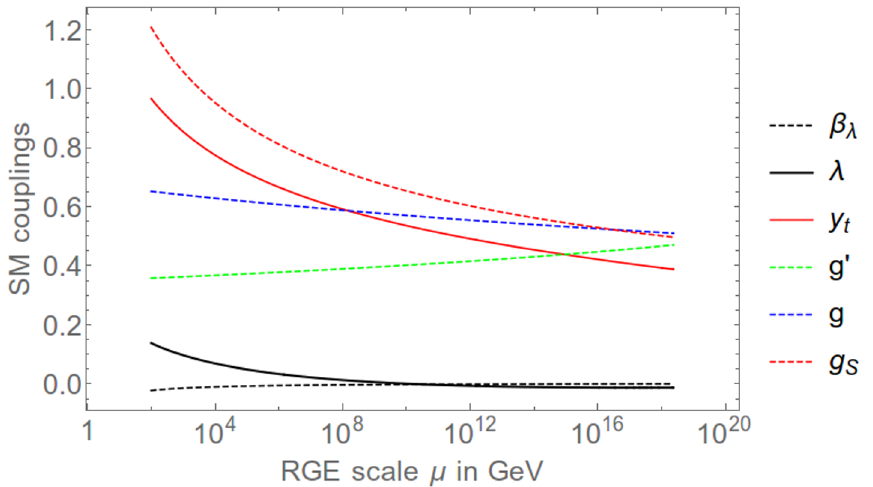
Figure 4 . Flow of the MS standard parameters λ, y t , g 0 , g, g S and β λ according to the renormaliza- tion scale µ . In addition to the electroweak contour conditions discussed in the text, ξ ( M P ) = 1000 was used in order to obtain the points.